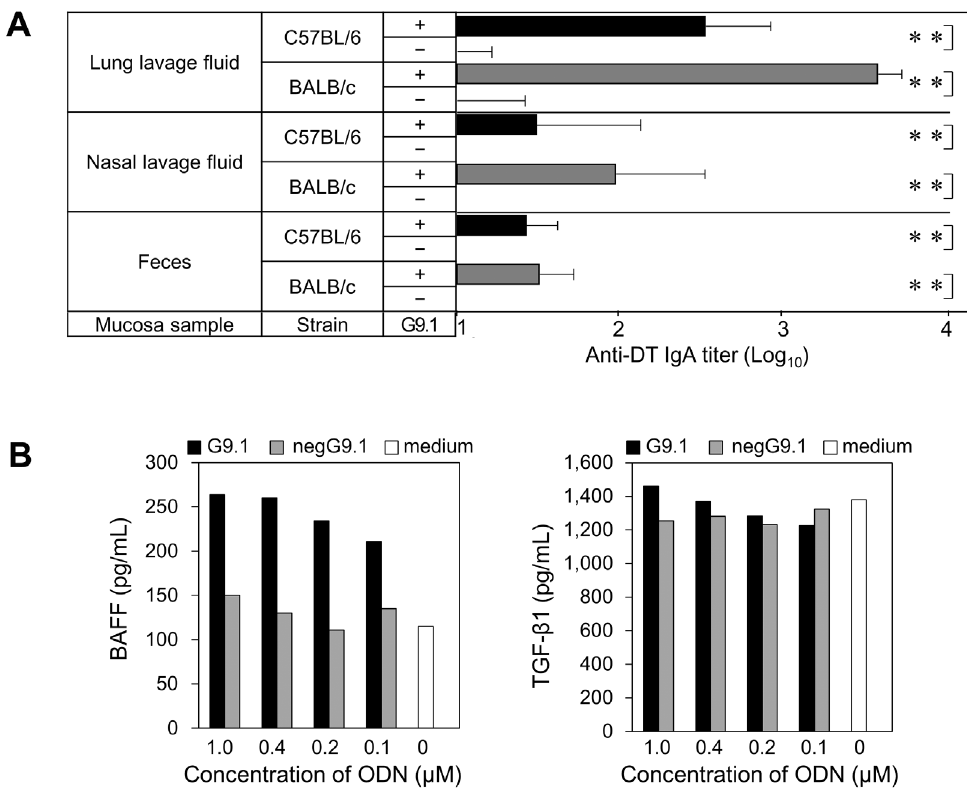
Figure 6. Nasally administered G9.1 promoted mucosal IgA response. A , BALB/c and C57BL/6 mice were immunized intranasally with 2 Lf DT with or without 20 m g of G9.1 on days 0, 14, 21, and 28. Lavages from the lungs and nasal cavity and the supernatants of the feces mixture were prepared on day 35 and anti-DT IgA titers measured. ** p , 0.01 by t -test (n=5). Three independent experiments yielded nearly identical results. B , BM cells (5 6 10 6 /mL) prepared from C57BL/6 mice were cultured for 24 h in medium alone or with varying concentrations of G9.1 or negG9.1. The culture supernatants were evaluated for BAFF and the activated form of TGF- b 1 by Quantikine immunoassay (ELISA Kit). Data are from one of two independent experiments yielding nearly identical results. Shown as the means from duplicate assays.